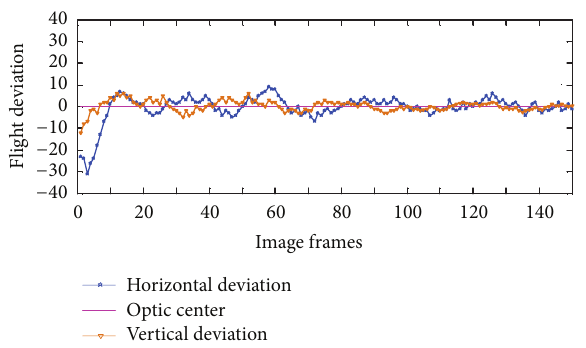
Figure 14: The horizontal deviation of autonomous